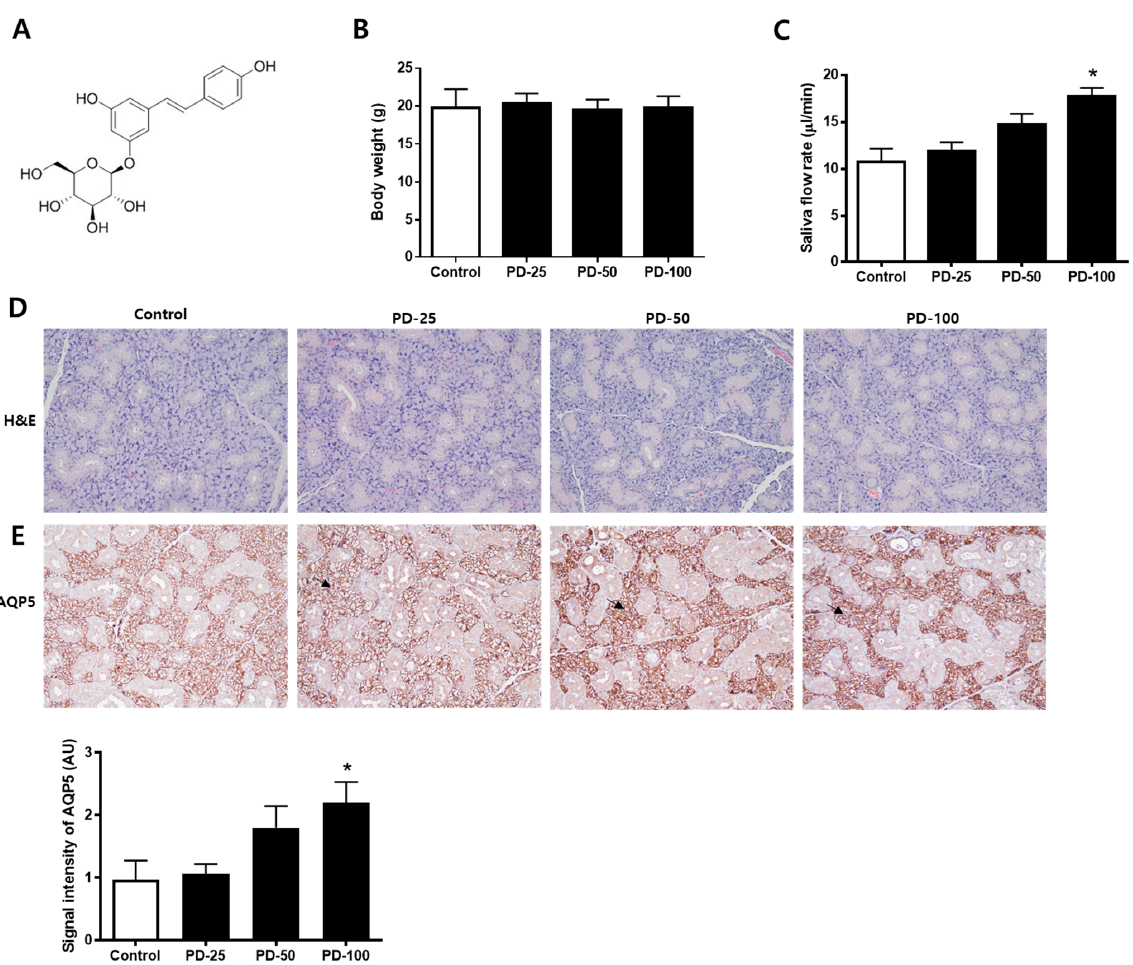
Figure 1. Effect of polydatin in the normoglycemic mice. ( A ) Chemical structure of polydatin. ( B ) Body weight. ( C ) Salivary flow rate. ( D ) Representative submandibular glands were stained with H&E. ( E ) Immunohistochemical staining for AQP5. Quantification of the AQP5 signal intensity. Arrows indicate AQP5 positively stained cells. The values in the bar graphs represent the means ± SD, n = 5. * p < 0.05 vs. normal control group.